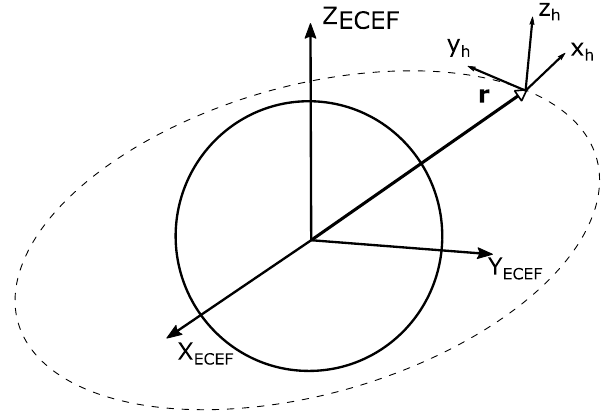
Figure 10. Hill frame and its relationship to ECEF.